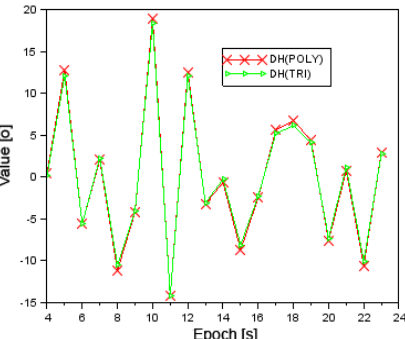
Figure 5. The values of DH parameter based on polynomial and trigonometric method.